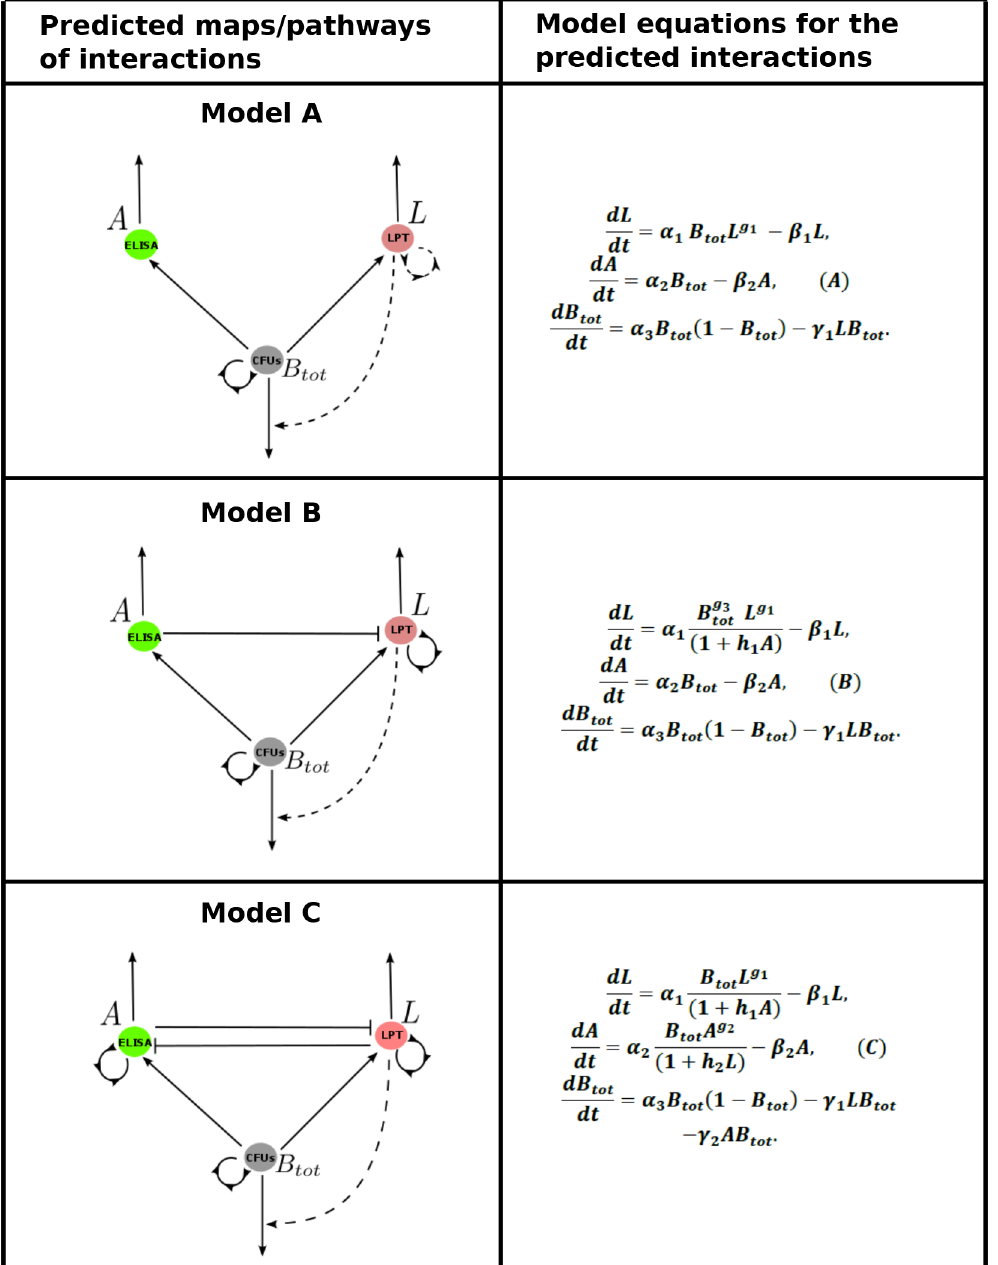
Fig 3. Predicted immune interactions that explain MAP shedding patterns. In graphs for Model A, B and C, lines ending with an arrow indicate stimulation (induction or up-regulation), lines ending with a flat bar represent suppression or inhibition and broken lines represent predicted effects that have varying effects (from strong to week) within each group, while solid lines represent strong effects within a group. Lines represented with a semi-circle with arrows represent self-stimulation/proliferation or